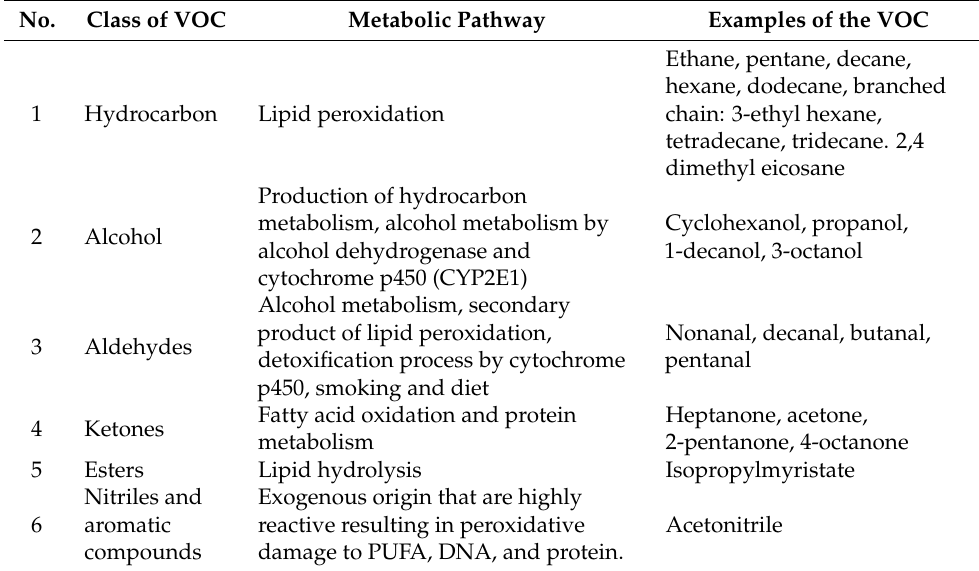
Table 2. Biological VOCs and potential metabolic